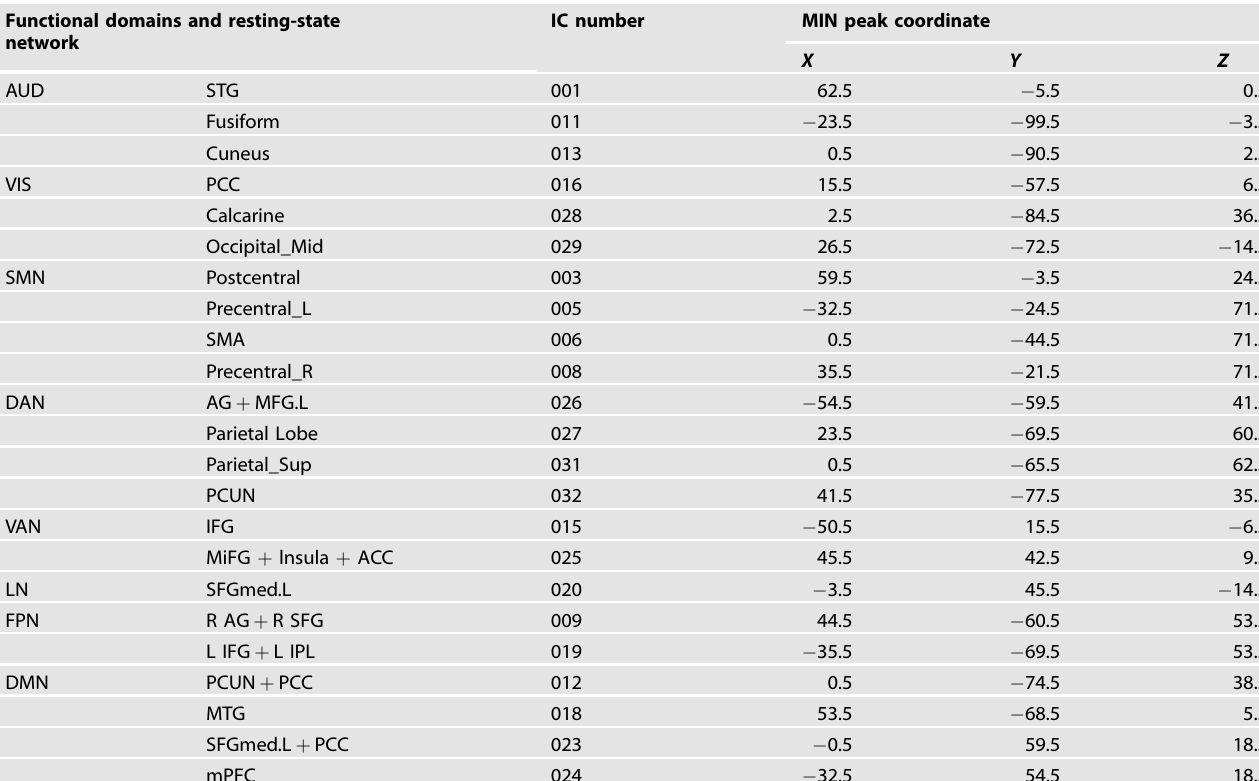
Table 2. Independent components sorted into functional